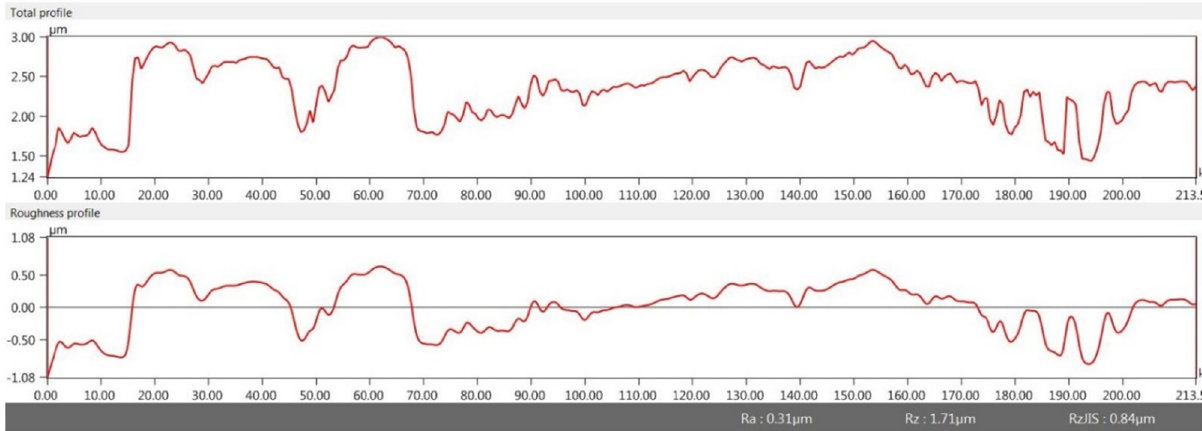
Figure 2: Surface roughness